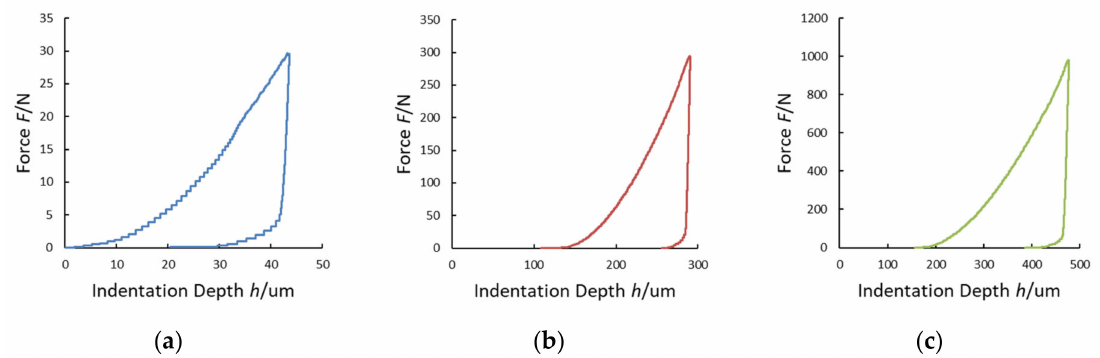
Figure 9. Loading-unloading curves of the HV tests on copper alloy: ( a ) HV3; ( b ) HV30; ( c ) HV100.